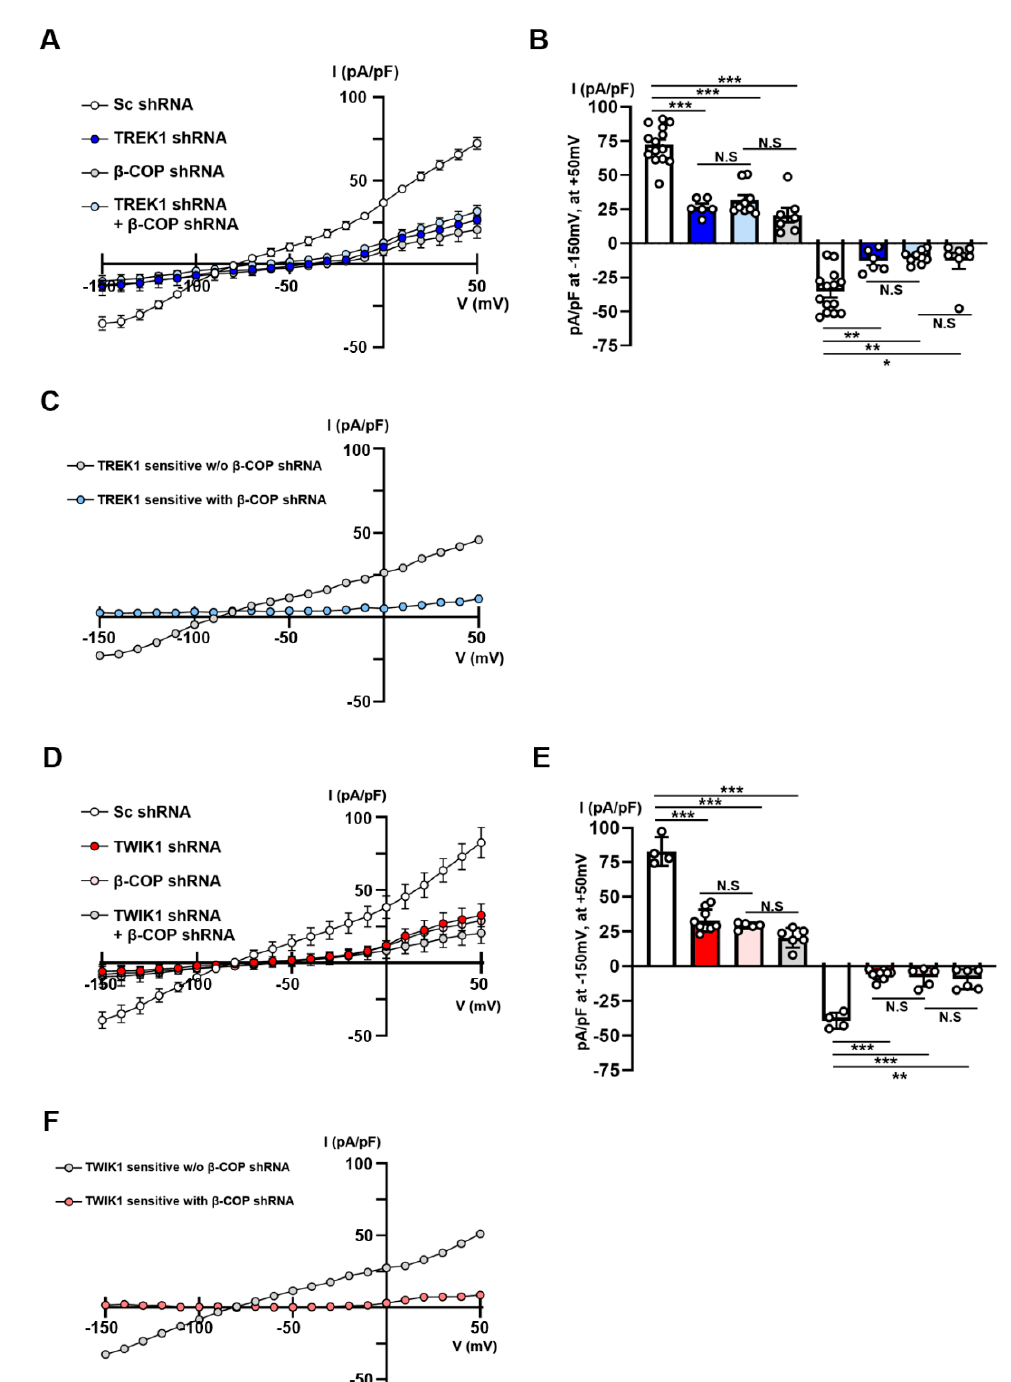
mV ( β -COP shRNA-infected astrocytes with Spardin) (Figure 7E). These data suggest that TWIK1/TREK1 heterodimeric channels contribute to passive conductance under β -COP deficiency. Therefore, β -COP modulates passive conductance by controlling the trafficking of TWIK1/TREK1 heterodimeric channels through protein–protein interactions with β -COP.